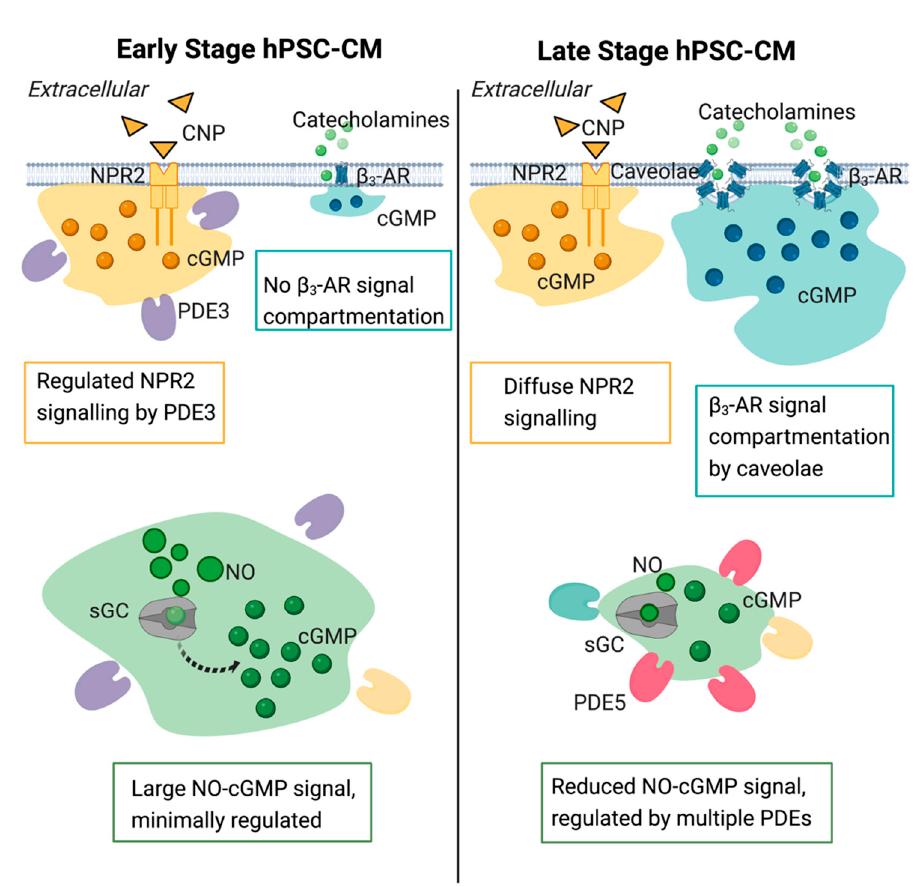
Figure 9. Schematic of the three cGMP pathways via nitric oxide (NO), natriuretic peptide receptor (NPR), and β 3 -adrenoreceptor (AR) stimulation in induced pluripotent stem cell derived cardio- myocytes.